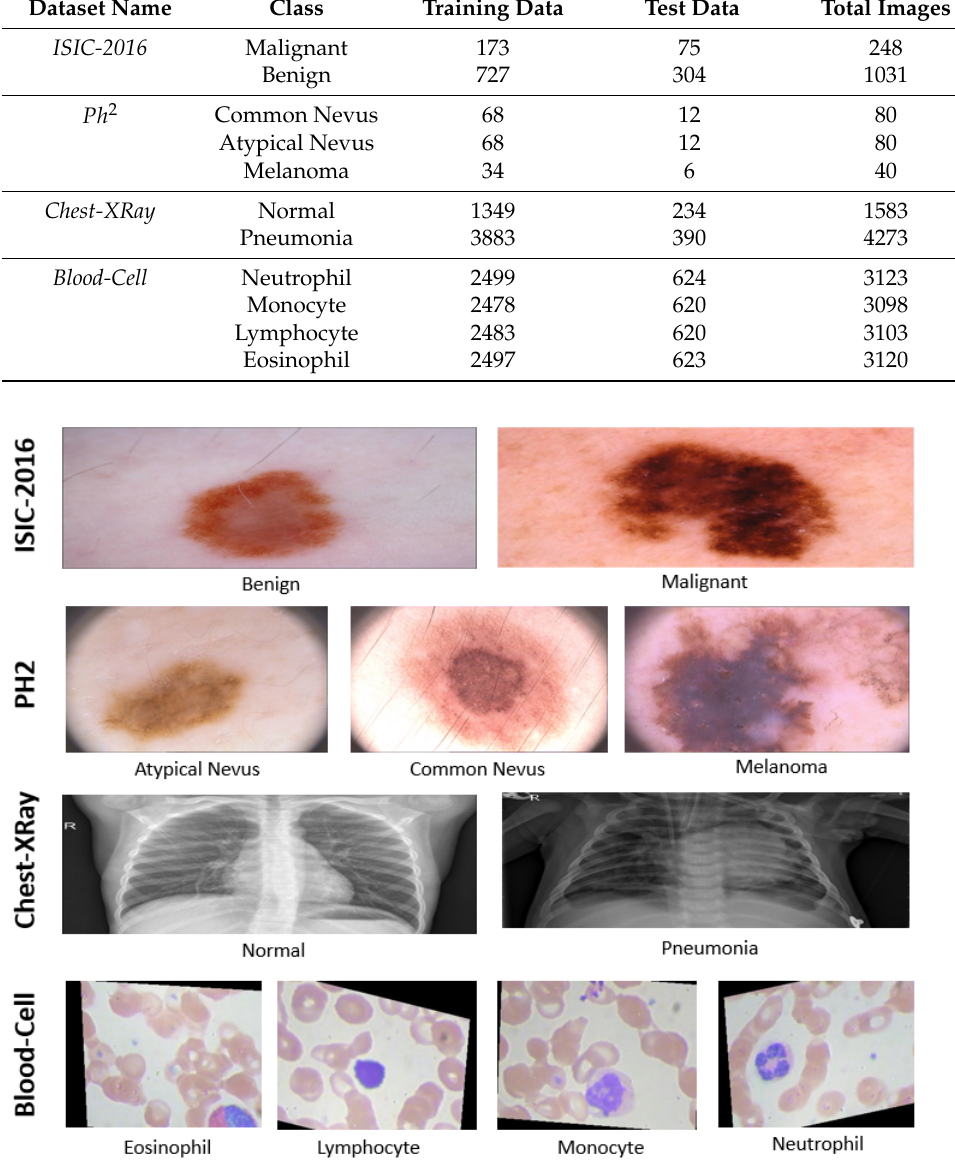
Figure 5. Samples of medical images for the classification task from the four selected databases. Raw images were used to train the CNN models and the extracted deep features were used by the FS optimizer to select the best features from these deep features. The number of deep features from the Chest-XRay and ISIC-2016 datasets was 128 features, and 512 deep features from the PH2 and Blood-cell datasets were utilized. Optimized feature sets were used to train the three classification algorithms of DT, LDA, and SVM. For a fair comparison, we used the default settings for the three classifiers in all experiments. In total, we conducted five experiments with different datasets and different algorithms to test the proposed algorithm. Some datasets were used to build binary classifiers, such as ISIC-2016 and Chest-XRay; the PH2 dataset was used to build a three-class classifier, and Blood-Cell was used to build a four-class